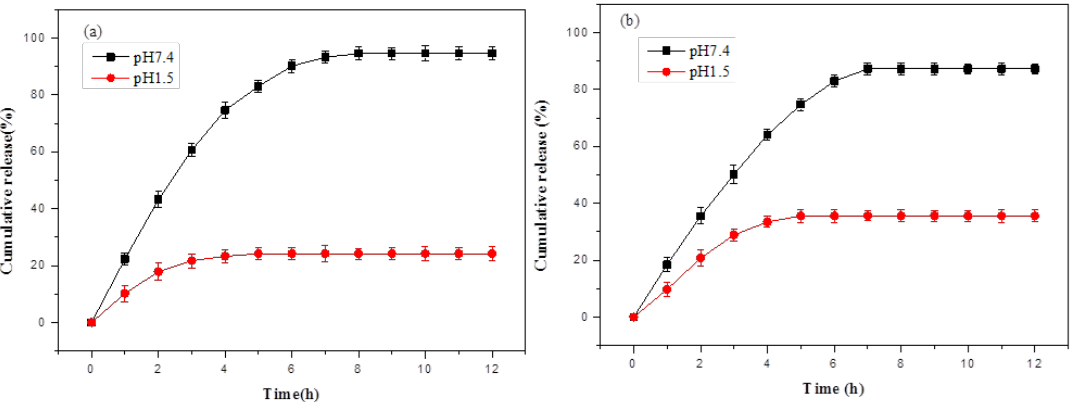
Figure 6. In vitro cumulative drug release from the drug-loaded gel-3 in simulated gastric and intestinal fluids at 37 ◦ C: ( a ) acetylsalicylic acid and ( b )